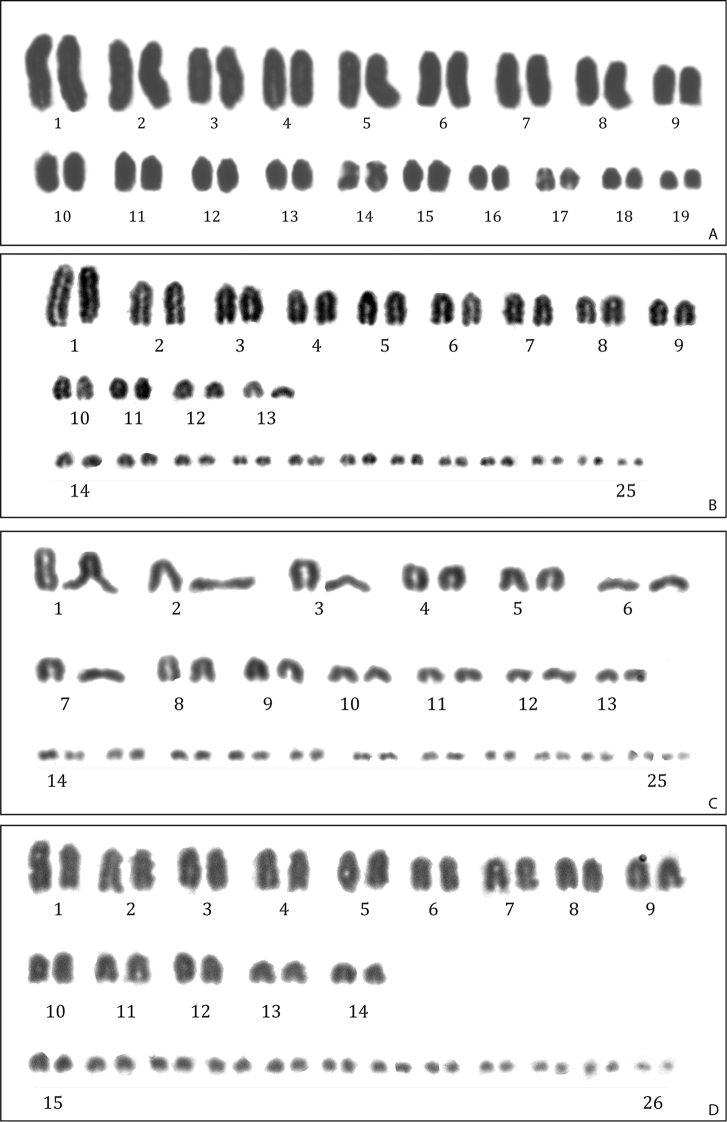
Karyotypes of APhyllodactylus sp.3 (2n = 38, RCMX69 male) BHolcosus
festivus (2n = 50, RCMX224 female) CHolcosus
undulatus
parvus (2n = 50, RCMX77 female) DAspidoscelis
deppii (2n = 52, RCMX76 female).